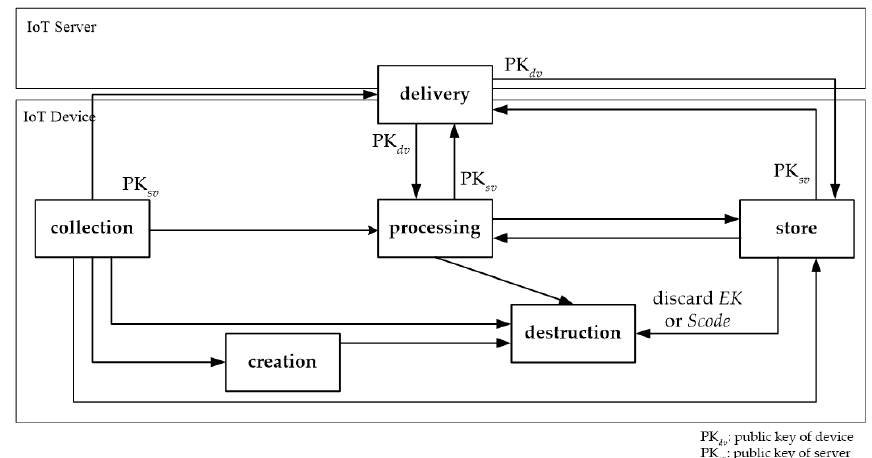
Figure 2. Personal information flow and lifecycle